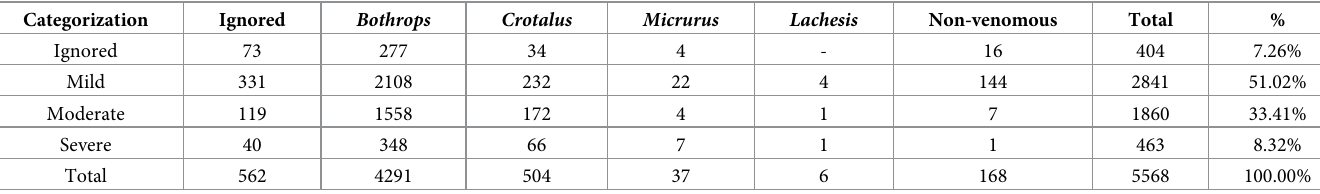
Table 3. Categorization and number of snake envenomations per snake genus in Mato Grosso Do Sul state, Brazil, between 2007 to 2017.